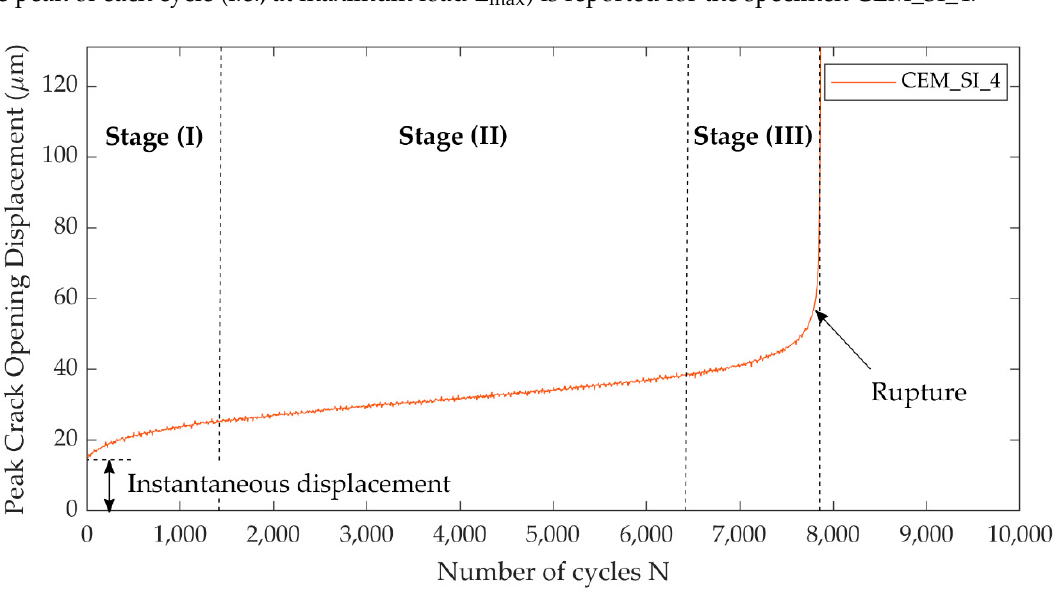
Figure 12. Three-stage fatigue evolution of the peak crack opening with increasing number of cycles.